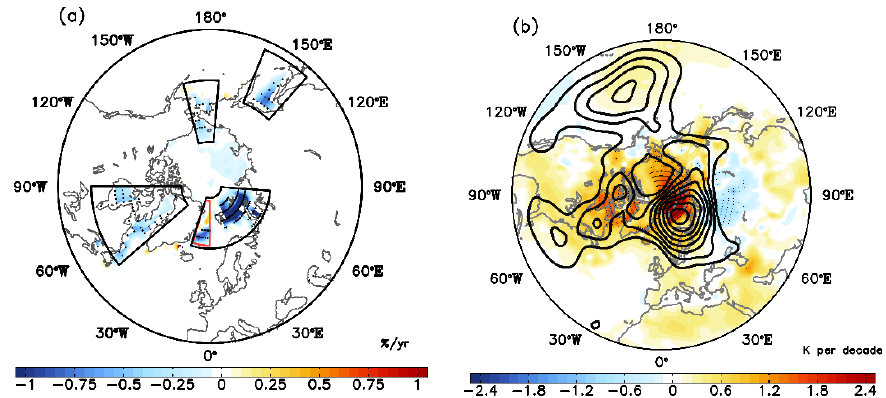
Figure 1. ( a ) Linear trend distribution of the Arctic sea ice cover (SIC) for winters (DJF) from 1979–2016. Four key sea regions (black boxes) are Baffin Bay, Barents-Kara Seas, Okhotsk Sea and Bering Sea. The small region in red box is Greenland Sea. ( b ) Regression pattern of the detrended winter 500-hPa geopotential height (contours) and surface atmosphere temperature (SAT: shading) anomaly against the detrended DJF mean SIC anomaly across the whole Arctic during 1979–2016. The dotted areas represent values that are above the 95% confidence level based on a two-sided Student’s t test.